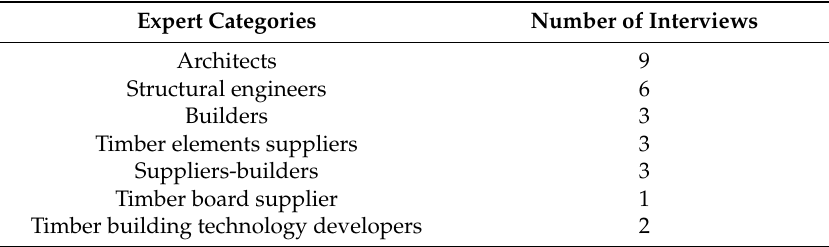
Table 2. Number of supply chain actors interviewed per